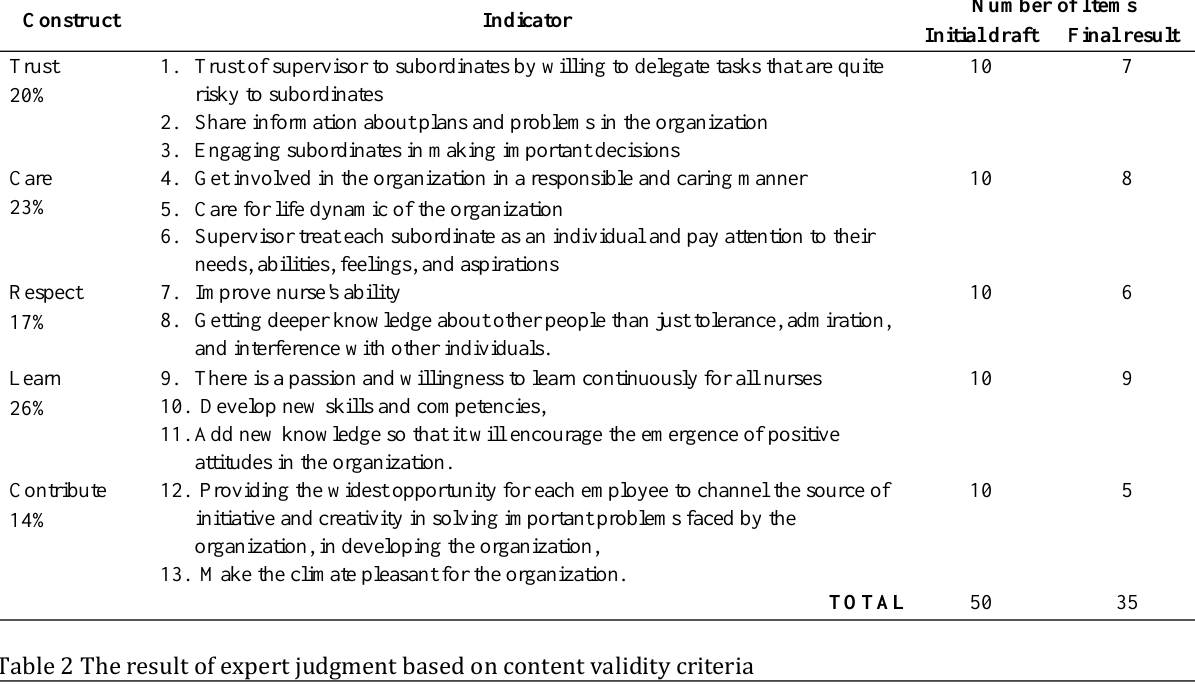
Table 1 Initial draft and final results for the outline quality of nursing work life instrument Construct